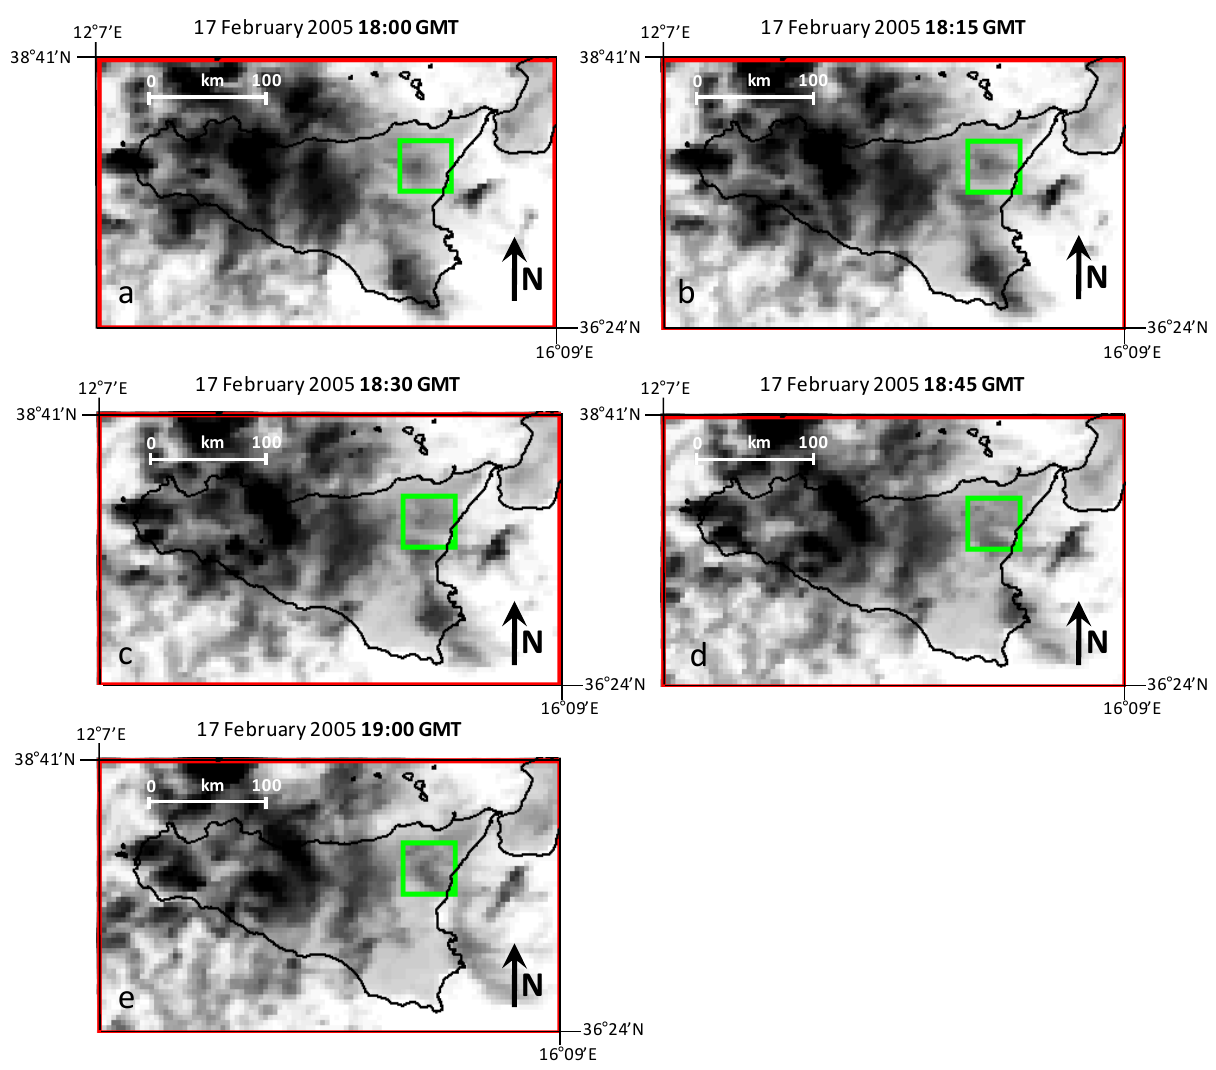
Figure 3. 15-minute temporal sequence of SEVIRI thermal infrared images (Ch9) of 17 February 2005 acquired between 18:00 GMT and 19:00 GMT showing a progressive cloud cover (dark pixels in the scenes indicate clouds) of the Mt. Etna area (green